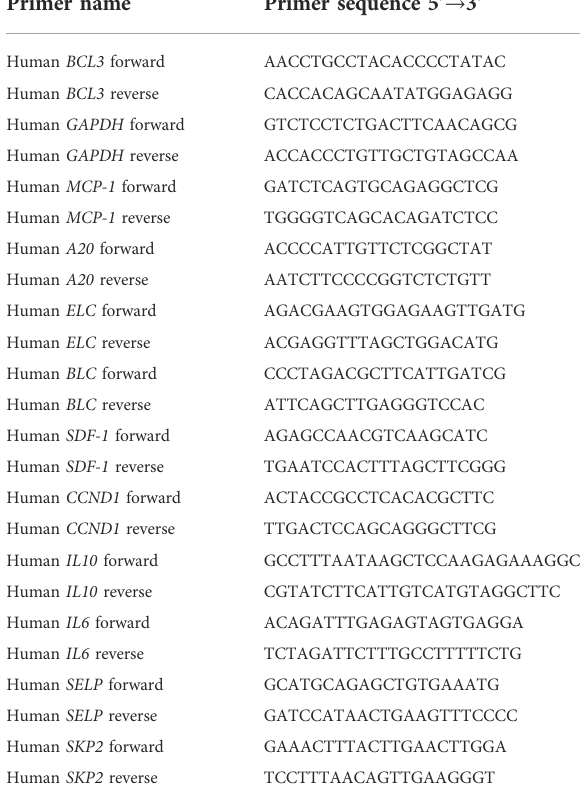
TABLE 1 The sequences of the primers used for